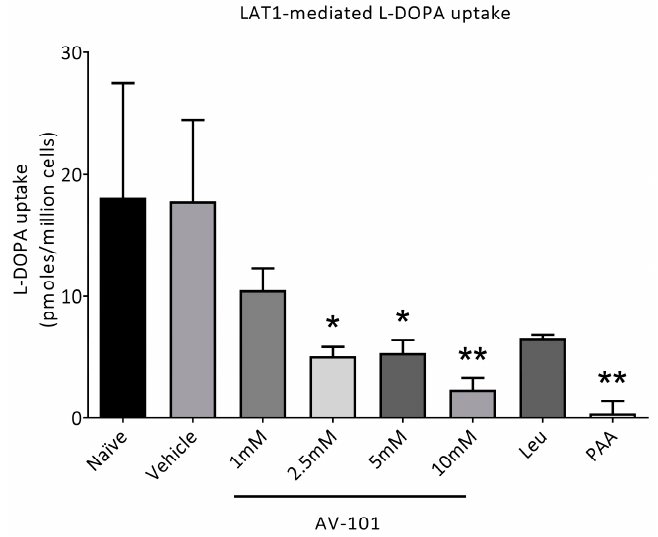
Figure 2. L-Dopa transport via LAT1 is inhibited by high concentrations of AV-101. The uptake